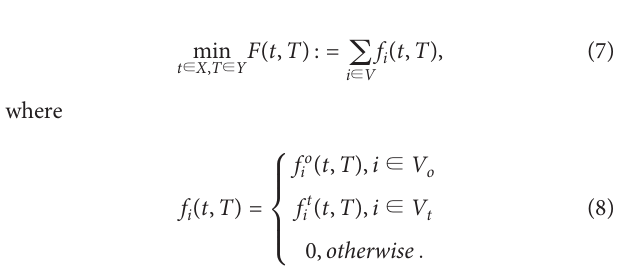
FIGURE 2 | (A) A geometrical diagram of a dose calculation. (B) Cost functions for organs at risk (OARs) and the tumor based on the calculated dose Di. d, a length of shield; S, source; P, the point of interest; (r_ ∥ ) ⃑ , parallel component; and (r_ ⊥ ) ⃑ ,